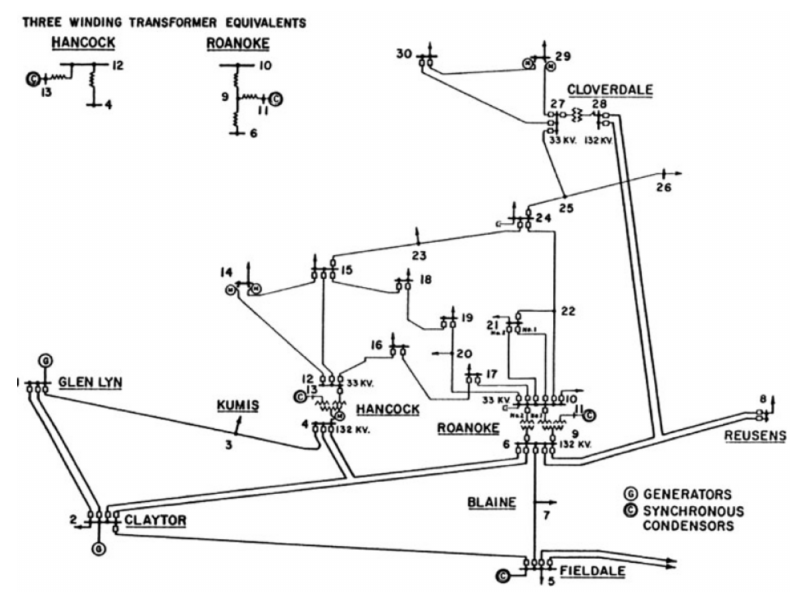
Figure 2. The IEEE 30-bus test system. Table 1. Simulation parameters for the IEEE 30-bus test